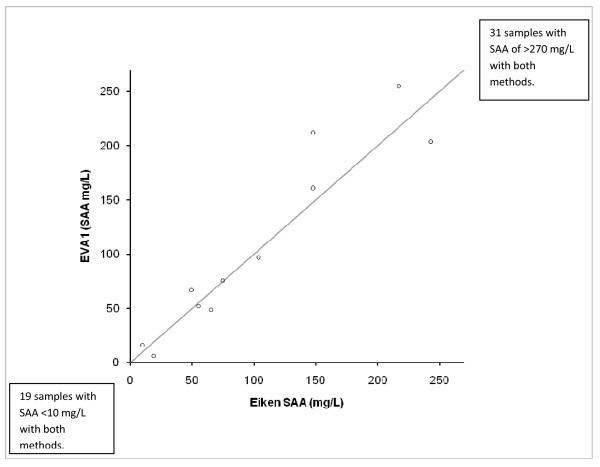
Method comparison between in-clinic assay (EVA1) and reference assay (Eiken). Eleven samples with SAA concentrations of 10-270 mg/L (assay range of EVA1) are plotted. The line represents y = x. One sample had a SAA concentration of <10 mg/L with the in-clinic method and 19 mg/L with the reference method (not shown in this figure). Nineteen samples had SAA concentrations of <10 mg/L with both methods and 31 samples had SAA concentrations of >270 mg/L with both methods.